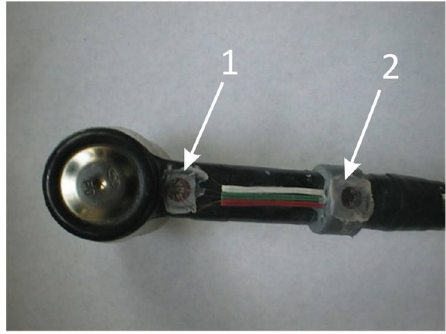
Figure 3. Strain gauge rosettes for measurement of the tie-rod loads [31]